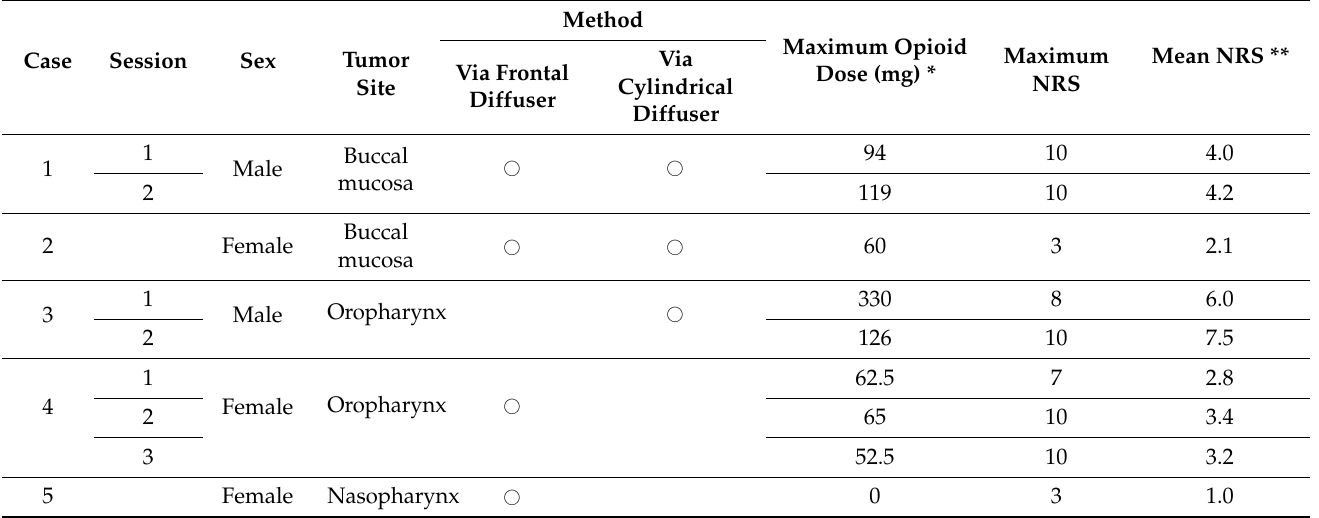
Table 3. Maximum opioid dose and NRS and mean NRS changes.